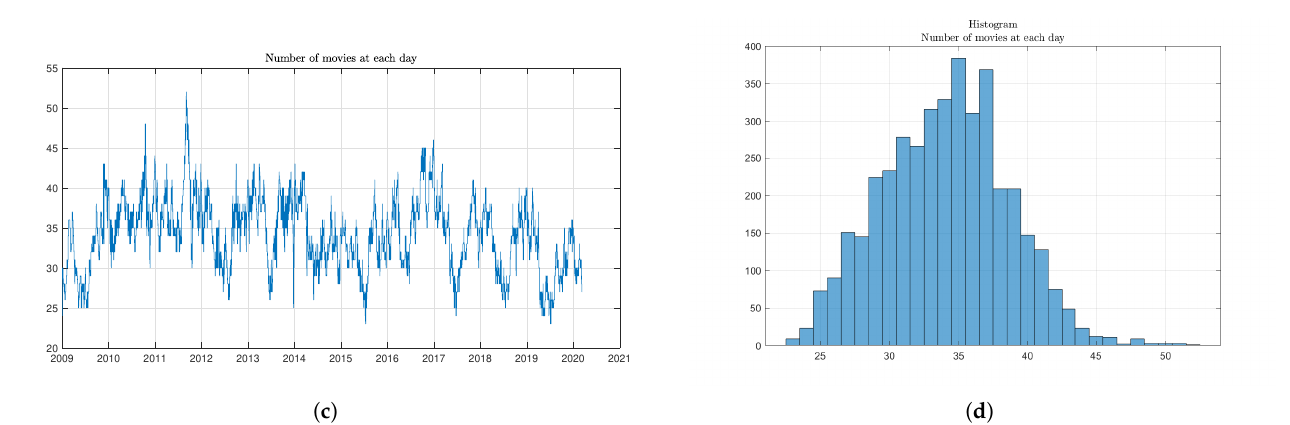
Figure 5. Top-left panel ( a ) shows the number of daily data for each movie in the data set. Labeled points highlight movies with a number of daily data above the 0.99 quantile. Bottom-left panel ( c ) shows the number of movies N t at each date t . In right panels ( b , d ) we see the corresponding histograms. 1—The Polar Express (2004) 2—The Hangover (2009) 3—Avatar